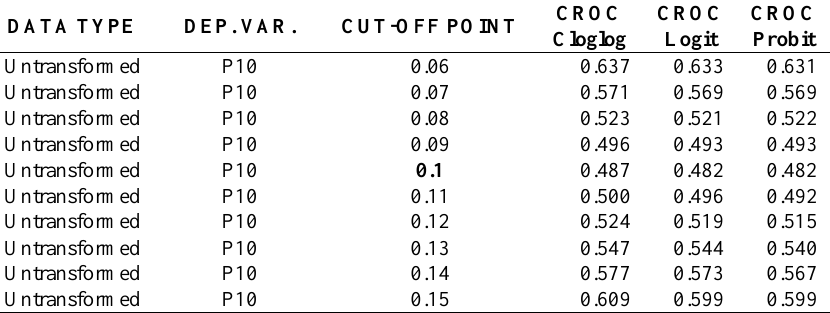
Table 7. Selection of the optimal cut-off point based on the CROC criterion. The P10 dependent variable